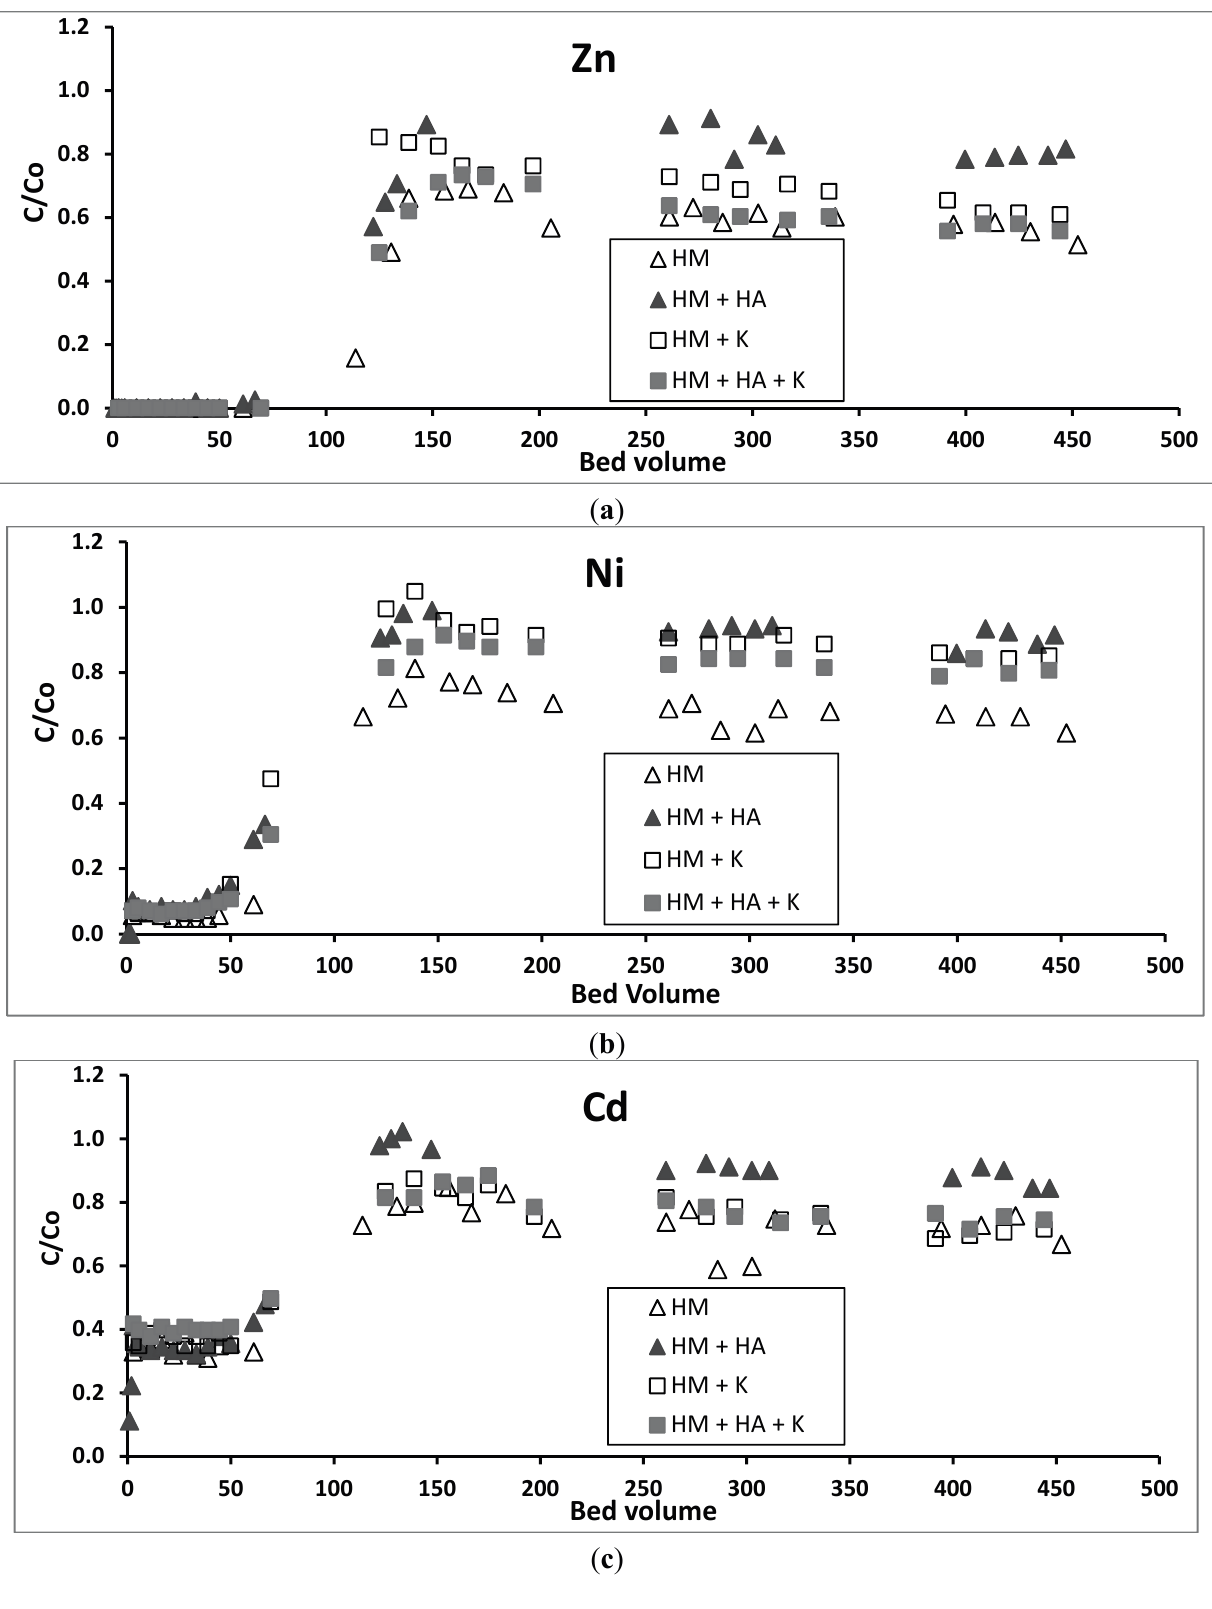
Figure 3. Breakthrough plots of ( a ) Zn, ( b ) Ni, and ( c ) Cd in the column study (HM— heavy metals, HA—humic acid,